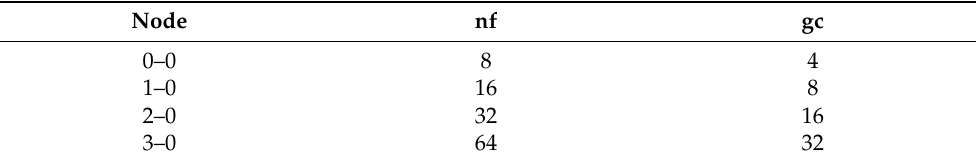
Table 1. Details of the parameters nf and gc in each Dense Unit used in our network.